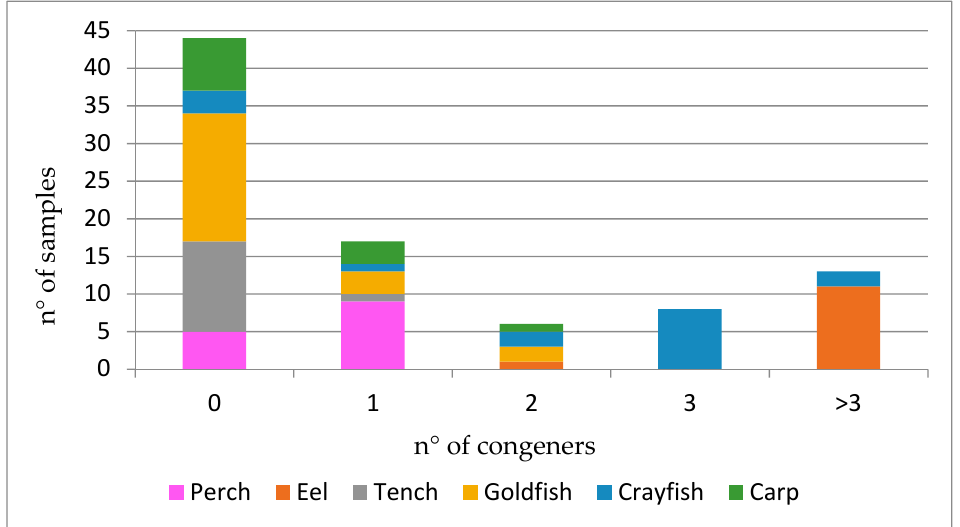
Figure 1. Number and presence of PBDEs and HBCDs in fish species.